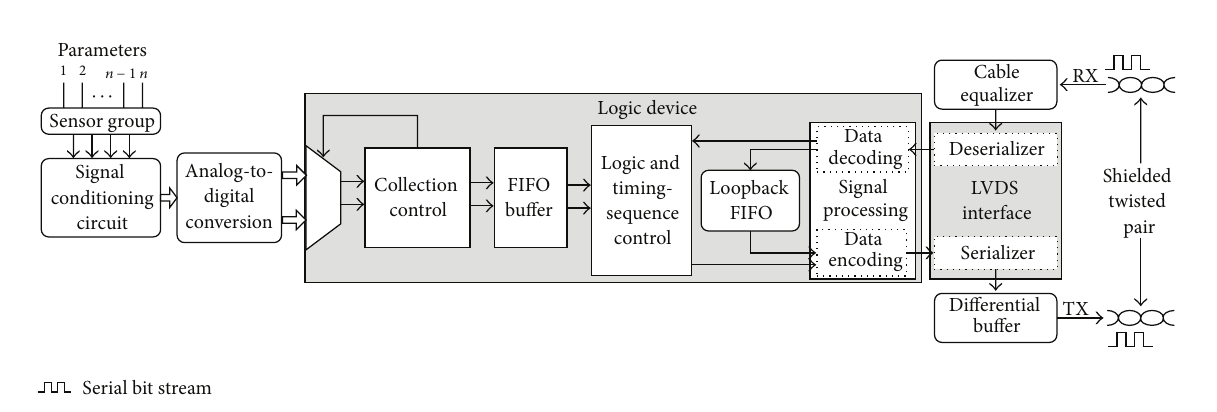
Figure 3: The circuit composition of a slave node.